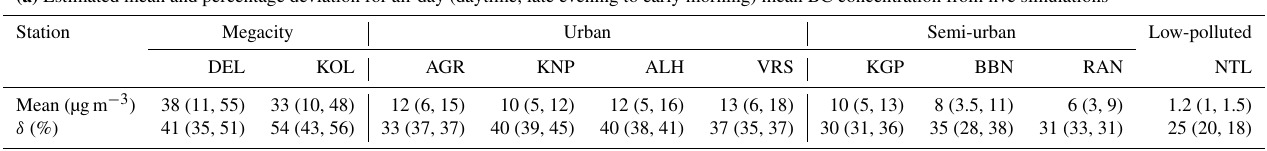
Table 3. (a) Estimated mean and percentage deviation ( δ , refer to Eq. 4) of the BC concentration from five simulations for the locations under study. (b) Summary of statistical analysis comparing the simulated BC concentration with